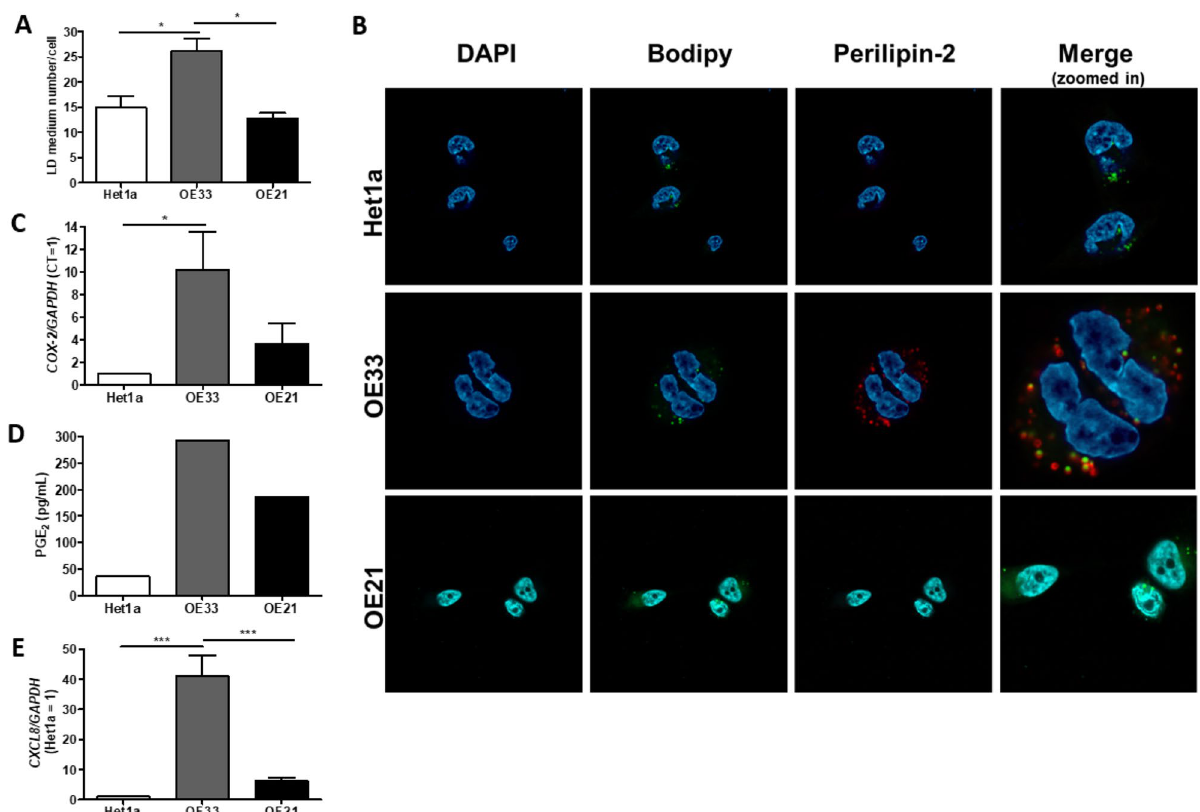
Figure 3. Evaluation of Lipid Droplets (LD) number and inflammatory mediators expression and/or secretion in esophageal cell lines. ( A ) LD quantification assessed by Oil Red O (ORO) staining in the normal immortalized esophageal cell line, Het1a, and in the esophageal adenocarcinoma (OE33) and squamous cell carcinoma (OE21) cell lines. ( B ) LD (by using Bodipy) and Perilipin-2 staining in Het1a, OE33 e OE21 cell lines. Blue color represents DAPI staining; Green color represents Bodipy staining; Red color represents Perilipin-2 staining. ( C ) COX-2 and ( E ) CXCL-8 mRNA expression, assessed by RT-qPCR, and ( D ) PGE2 secretion, assessed by ELISA, evaluated in Het1a, OE33 e OE21 cell lines. Experiments were performed in triplicate ***p <